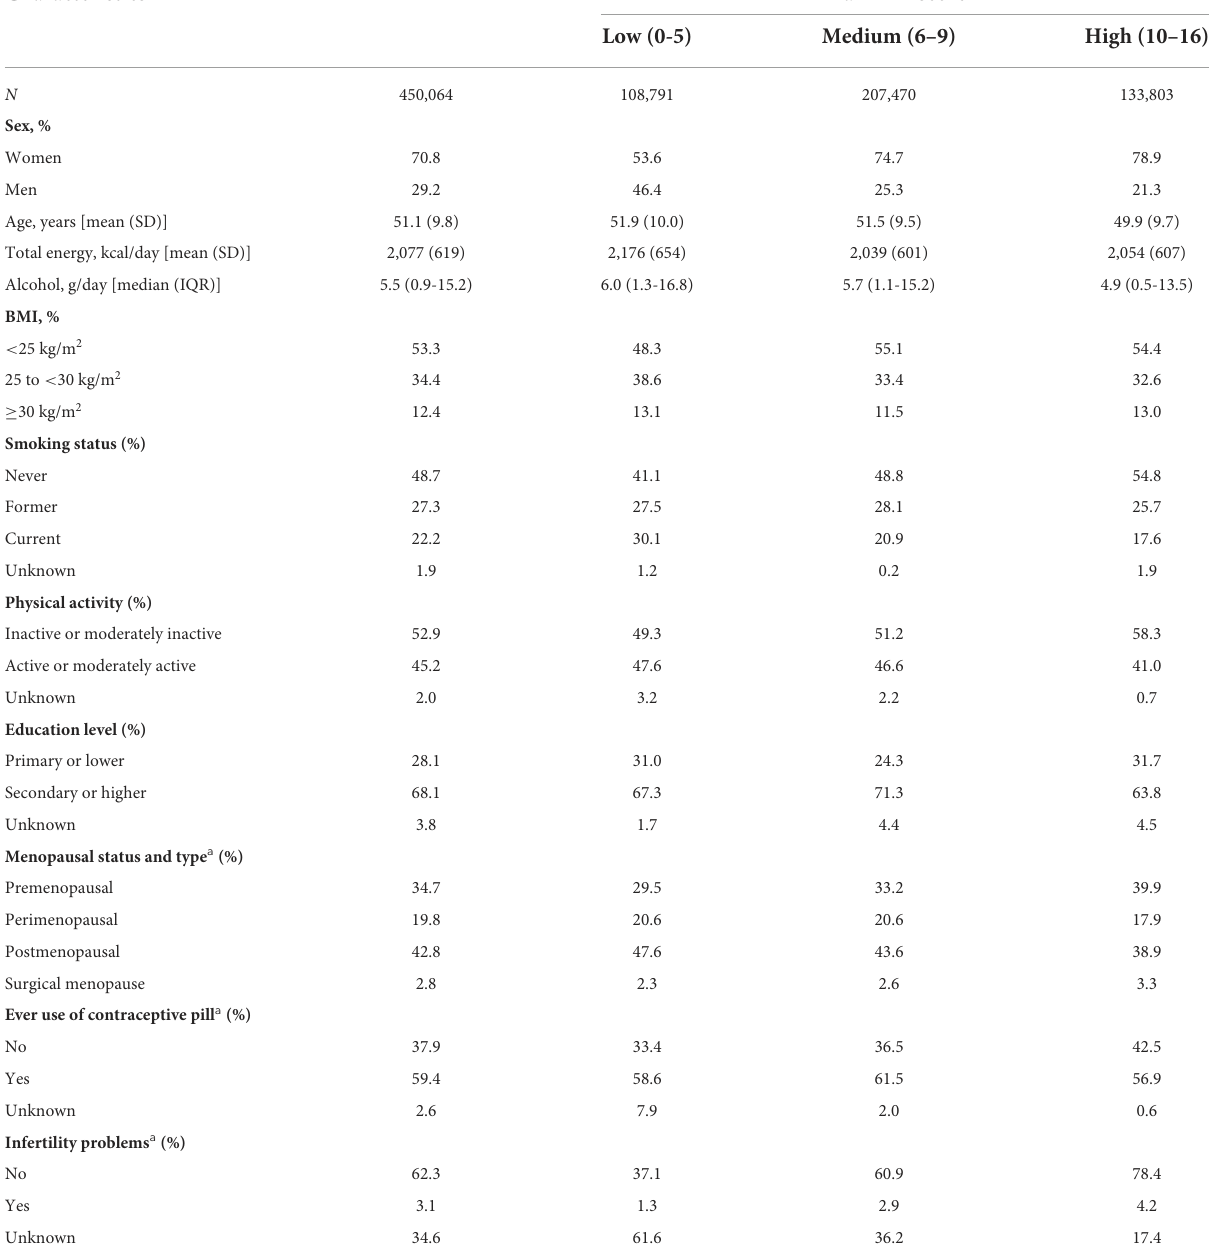
TABLE 2 Baseline characteristics of included participants from the EPIC study according to the adapted relative Mediterranean diet score (arMED). Characteristics